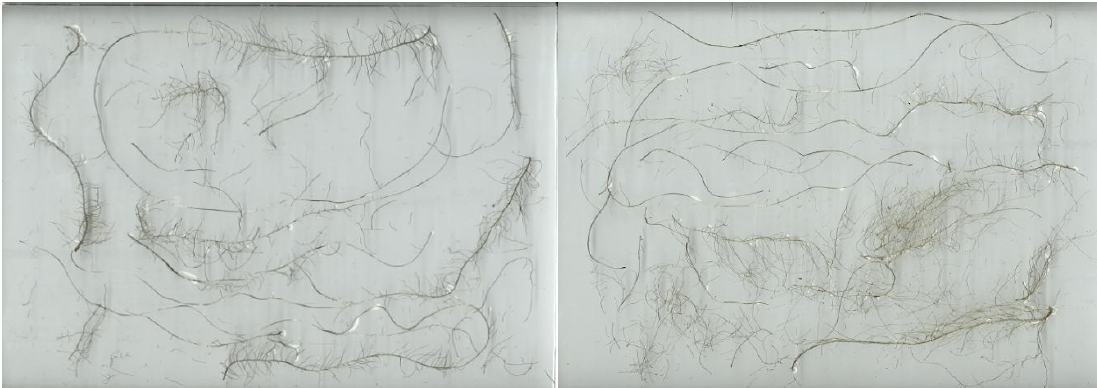
Figure 2. A magnification of individual lateral root strands from either hydroponic (on left) or aquaponic (on right) grown lettuce using deep-water culture methods (hydroponic treatment has the bold upper left root lateral shown).